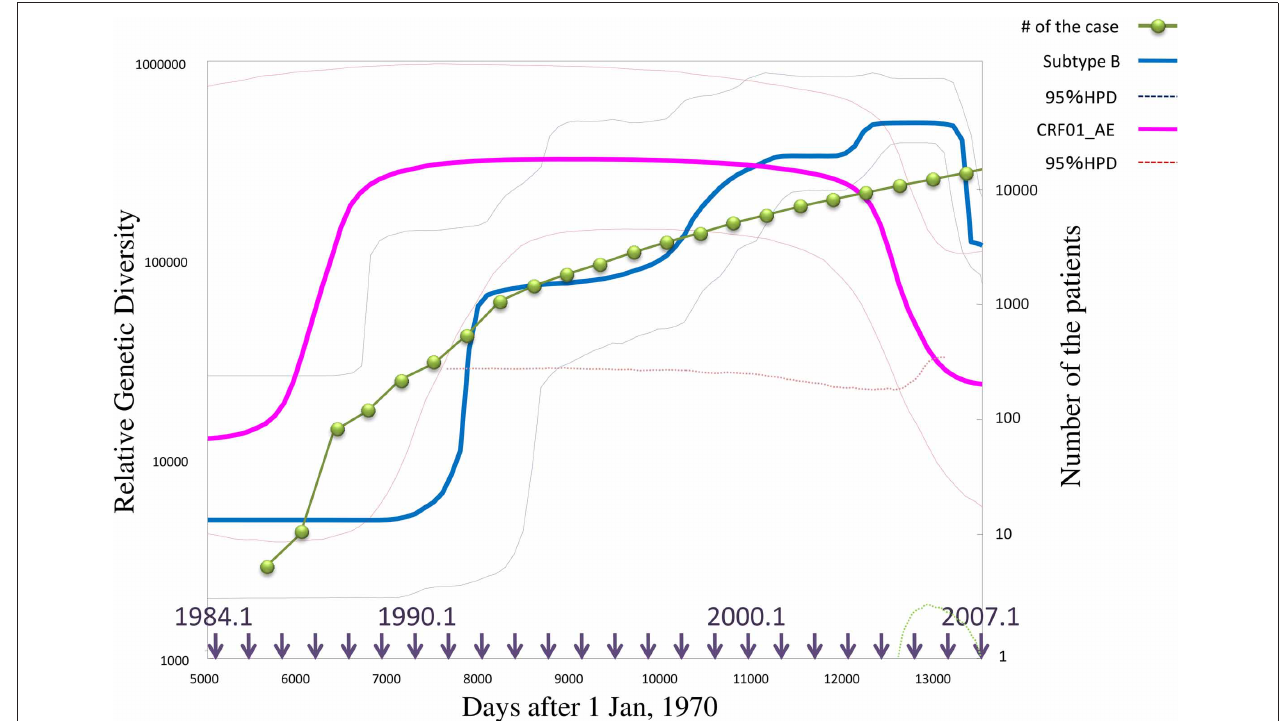
FIGURE 2 | Population dynamics inferred by Bayesian skyline plot analysis of HIV-1 epidemics in Japan. This graph represents the median estimate of the genetic diversities, i.e., relative population sizes, of HIV-1 Subtype B (blue line) and CRF01_AE (pink line) in Japan, with 95% posterior intervals (dotted line) estimated by BSP. The green line shows the number of HIV-1 infection cases in Japan. The horizontal axis indicates days after the